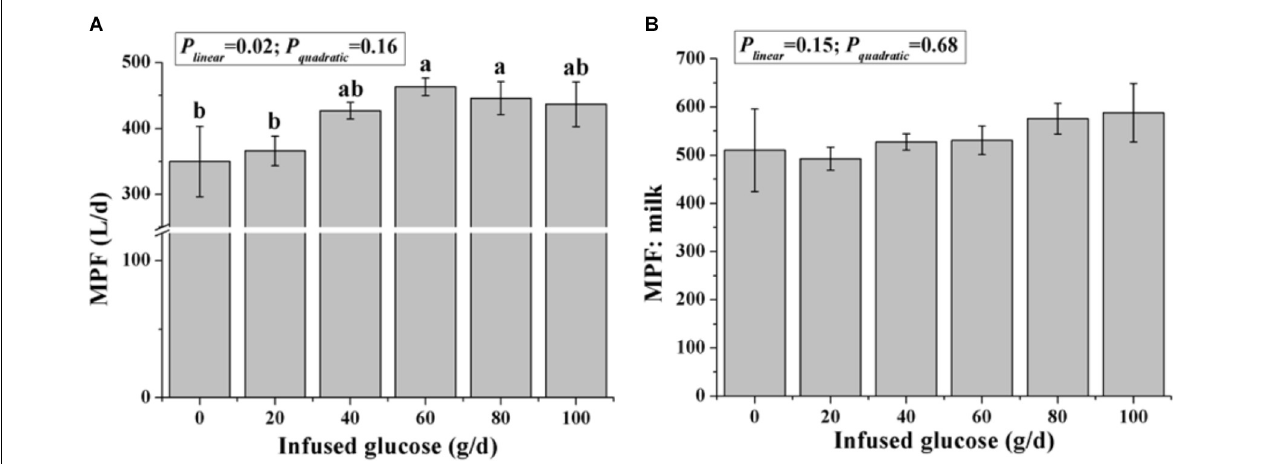
FIGURE 3 | Effects of increasing mammary glucose supply (0–100 g/d) through the external pudendal artery on mammary plasma flow [MPF, (A) ] and the ratio of mammary plasma flow and milk volume (B) . Error bar represents mean of standard